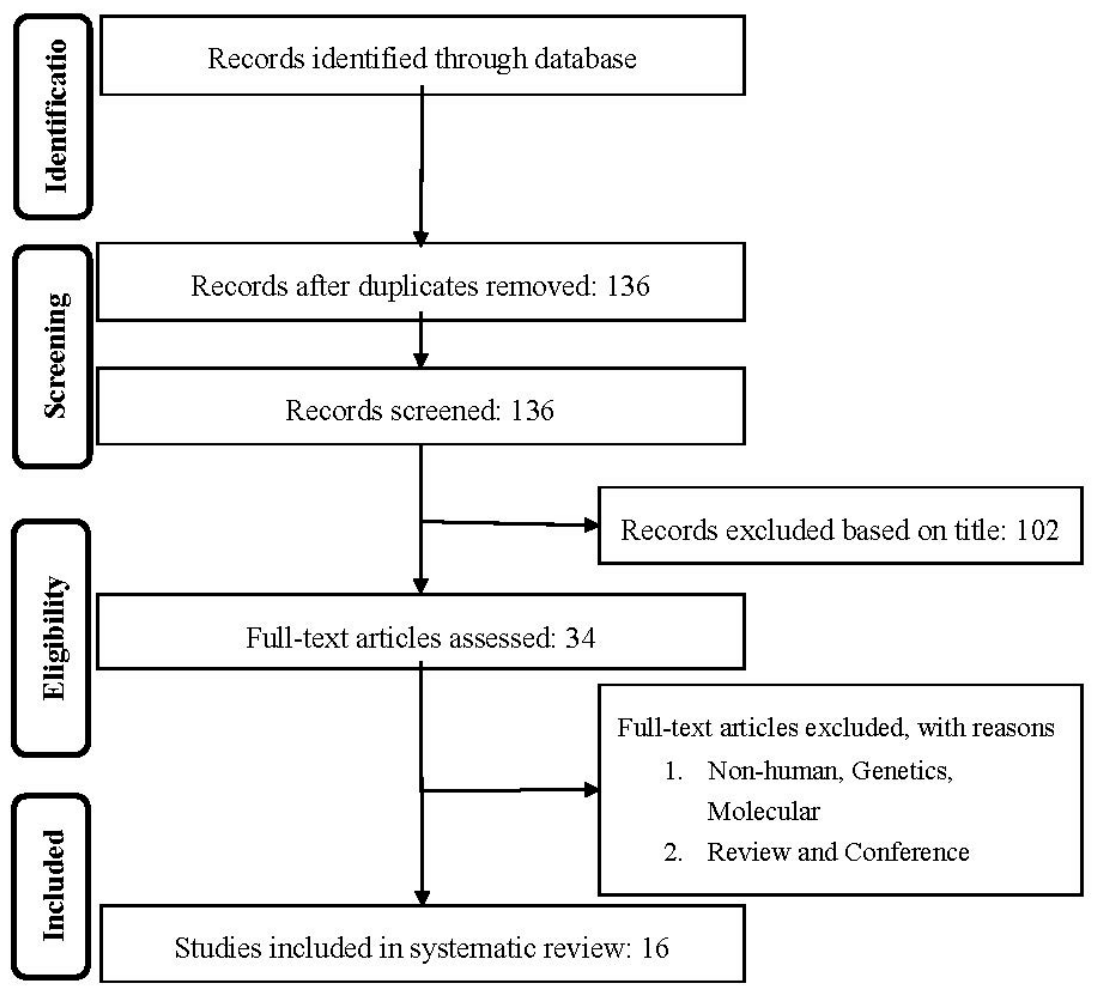
Figure 1. Flow chart of literature search for meta-analysis on flavonoid intake with total and cause specific mortality for the studies selection.